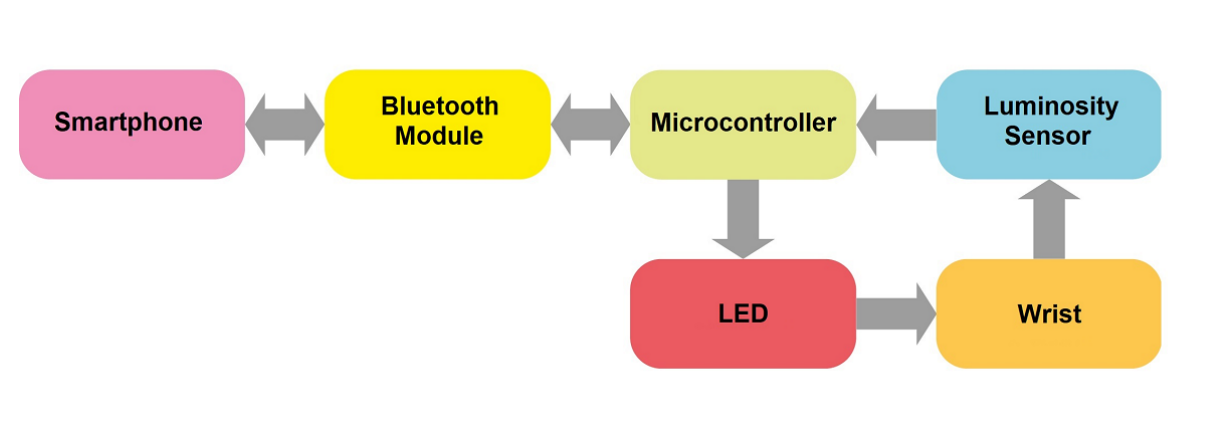
Figure 1. Block diagram of the blood pressure estimation